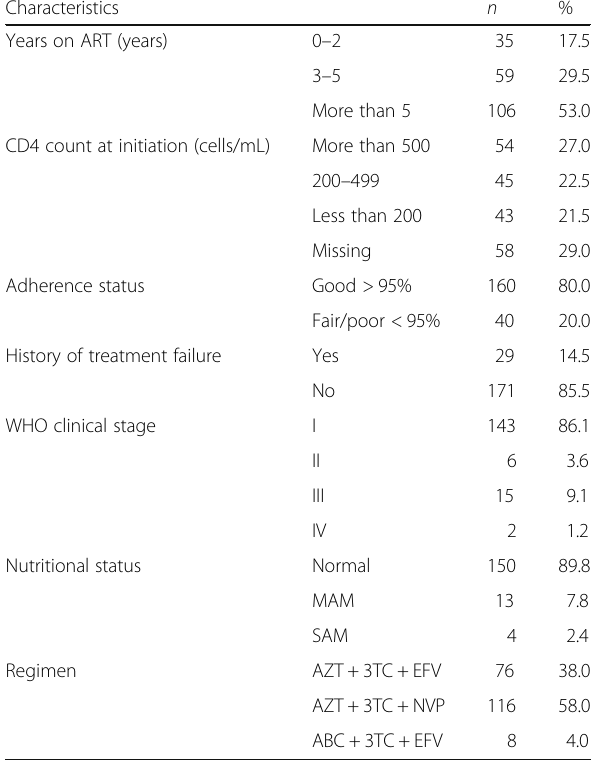
Table 2 Univariate treatment characteristics of adolescents